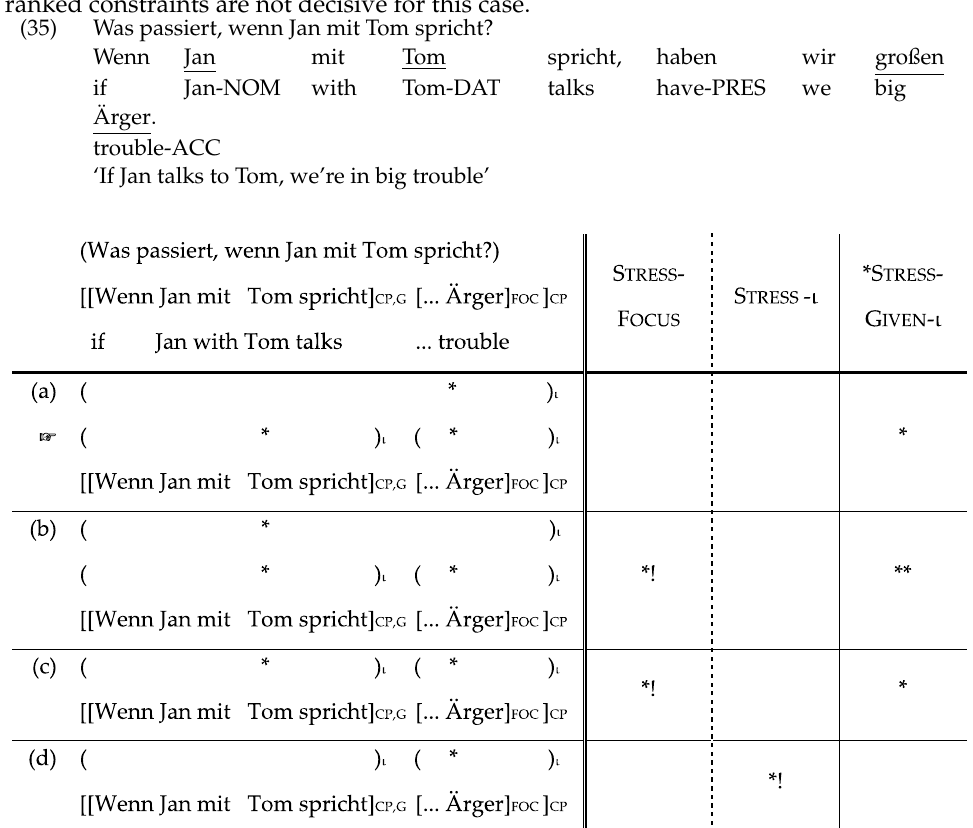
Figure 3. Prosodic structures predicted by S TRESS -F OCUS , S TRESS - ι >> *S TRESS -G IVEN - ι for an SVO sentence with a discourse-new verb and a discourse-given object under focus.